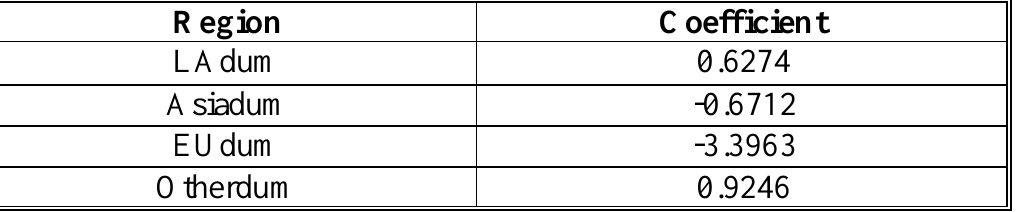
Trade liberalisation regression results with regional